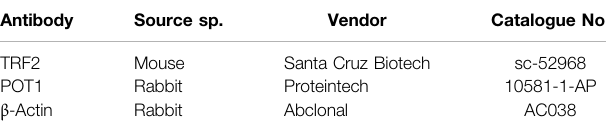
TABLE 1 | List of antibodies used for western blot in this study. Antibody Source